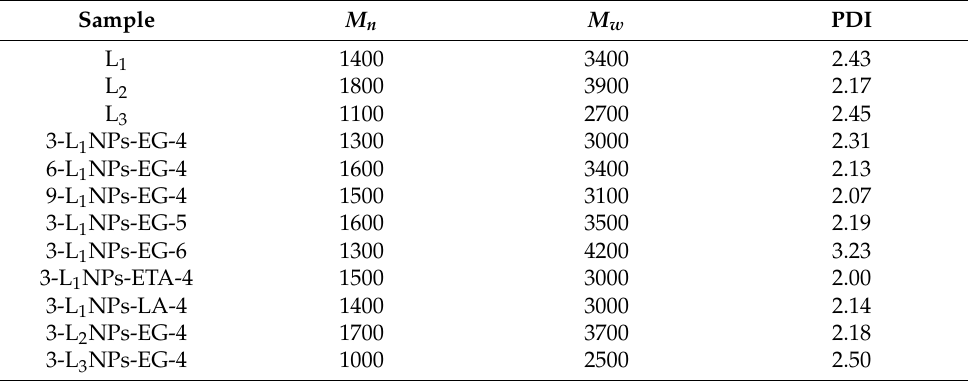
Figure 7. Fourier transform infrared spectroscopy (FTIR) spectra of lignin and LNPs. The molecular weight of the three pristine lignin samples and LNPs are analyzed by the GPC. The weight-average molecular weight ( M w ), number-average molecular weight ( M n ), and polydispersity index (PDI) are presented in Table 2. The process of treating lignin with DES at mild conditions, with increasing of the pre-dropping lignin concentration from 3 to 9 wt % and slight decrease in molecular weight and PDI shows that the main structure of the lignin aromatic ring is intact. Interestingly, when increasing pH from 4 to 6, molecular weight swells from 3400 Da to 4200 Da. Table 2. Weight-average molecular weight ( M w ), number-average molecular weight ( M n ), and polydispersity index (PDI) of lignin and LNPs.